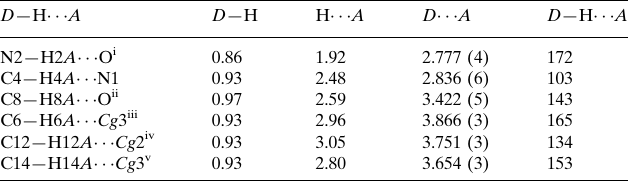
Hydrogen-bond geometry (A˚ , (cid:1)